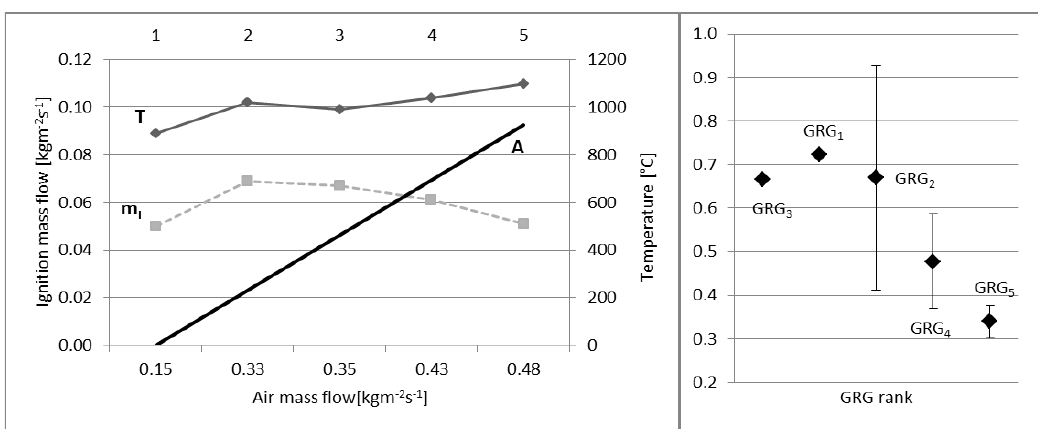
Figure 7. Air mass flow rate effect on the ignition mass flow rate and the front temperature of the wood pellets (wp), and the GRG rank.